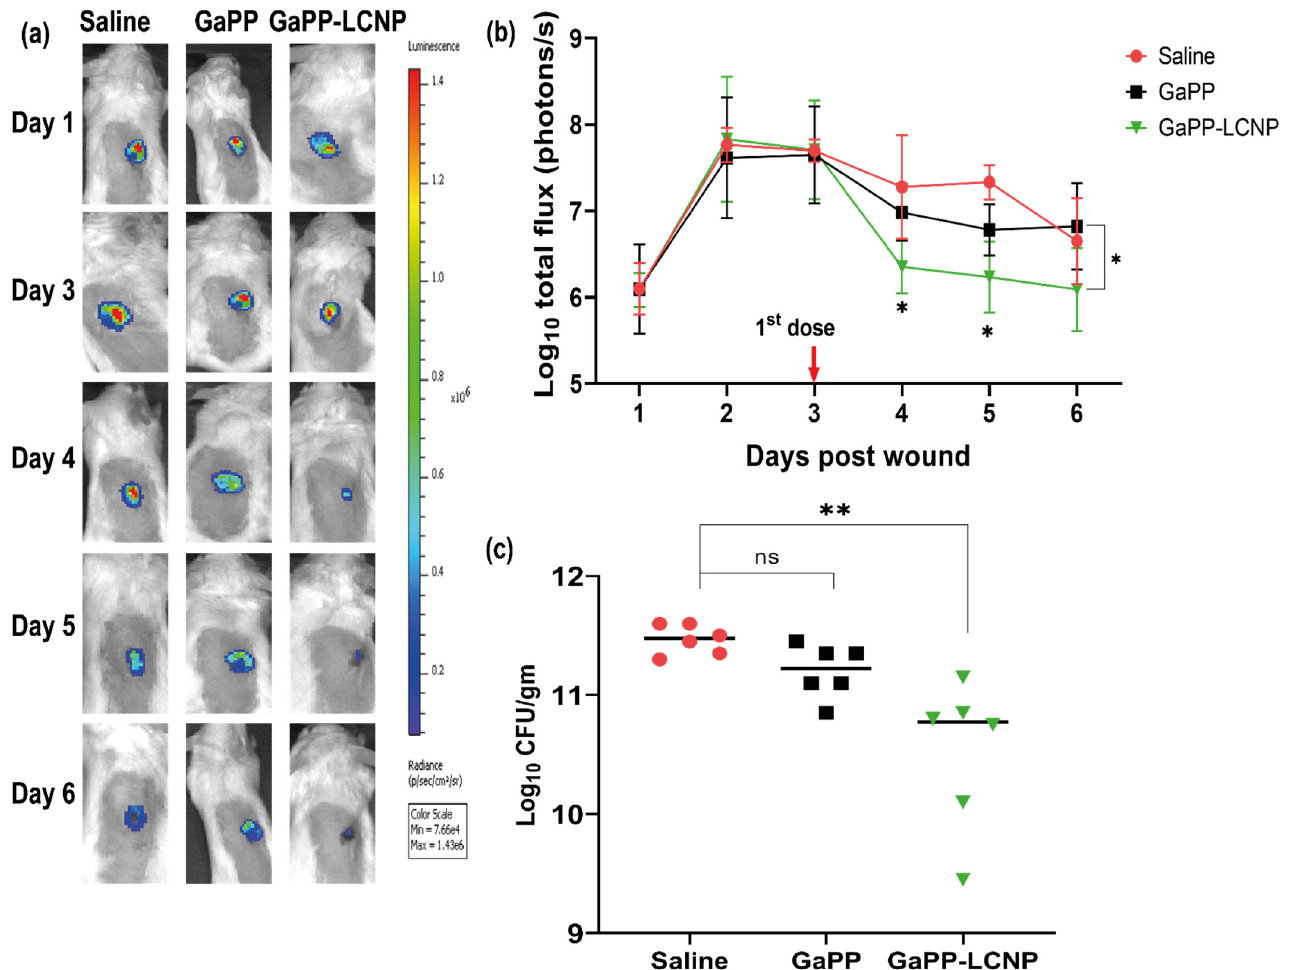
Figure 9. Illustration of the difference in the antibacterial activity between unformulated GaPP and GaPP-LCNP against Xen29 biofilms in infected full excisional wounds in mice. ( a ) Representative bioluminescent images showing infection progress in a single representative mouse from each treatment group; ( b ) corresponding determinations of the bacterial burden using average total flux (photons/s) showing significant reduction in the Xen29 luminescent signal following first treatment dose with GaPP-LCNP; ( c ) the viability of biofilms in wounds at the end point of the study after collection of tissue beds expressed as CFU/gm. Data presented as mean ± SD (three technical replicates for each wound per group, n = 6), ns: non-significant, * significant reduction p < 0.05, ** p = 0.001 (one-way ANOVA test followed by multiple comparison Dunnett’s test).